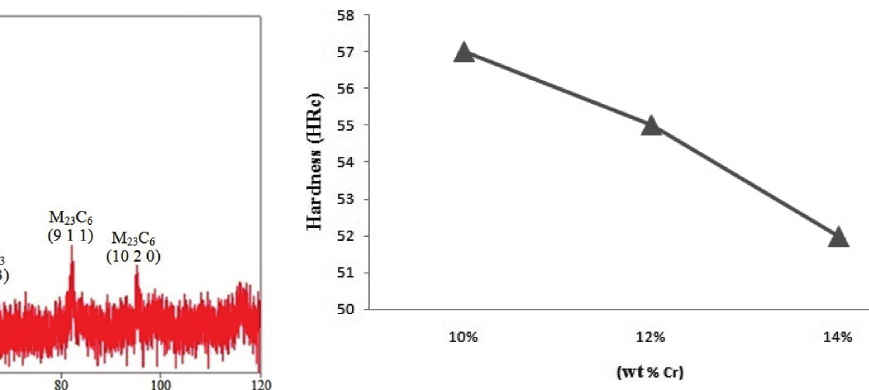
Fig. 4: XRD results of the alloy contain 10% Cr